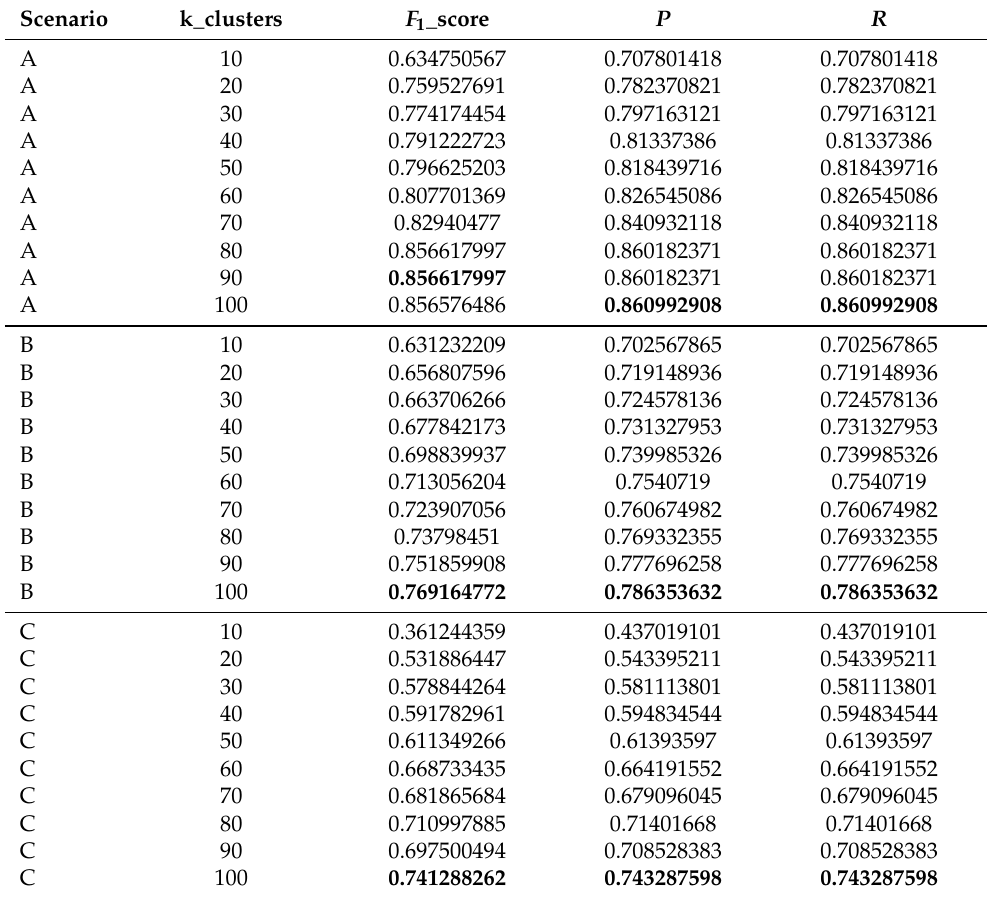
Table 3. The performance of the proposed self-supervised learning-based identification model for unknown Internet